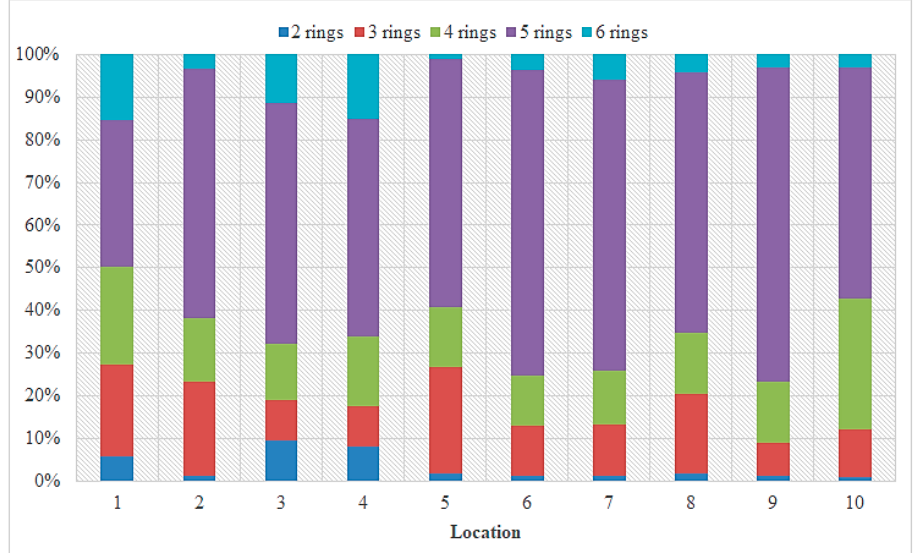
Figure 10 . Composition profile of total PAHs in sediment samples from the Volturno